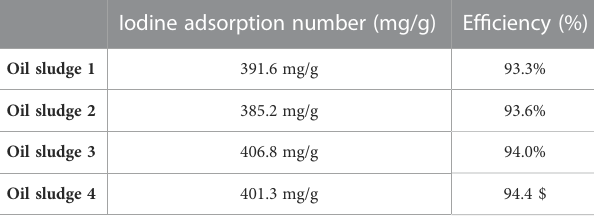
TABLE 3 The iodine number and ef fi ciency of prepared activated carbon. Iodine adsorption number